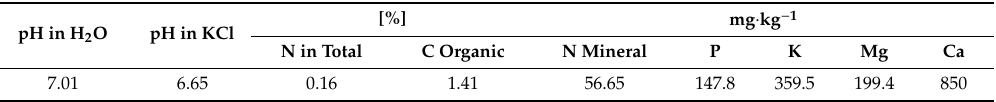
Table 1. Selected soil properties at the beginning and at the close of the experiment. Used for experiments mg · kg − 1 and after. [%] mg · kg − 1 pH in H 2 O pH in KCl N in Total C Organic N Mineral